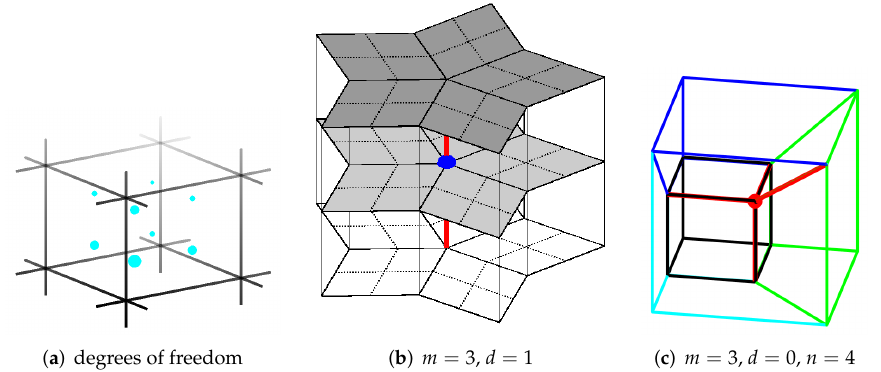
Figure 2. ( a ) The eight control abscissae c s α marked • of the degrees of freedom. ( b , c ) show irregularities. ( b ) Stacking an irregular bivariate quadrilateral mesh: Two irregular edges join at a semi-regular vertex • . ( c ) Four boxes in R 3 : one irregular point of valence n = 4 and four irregular edges of valence n 1 =